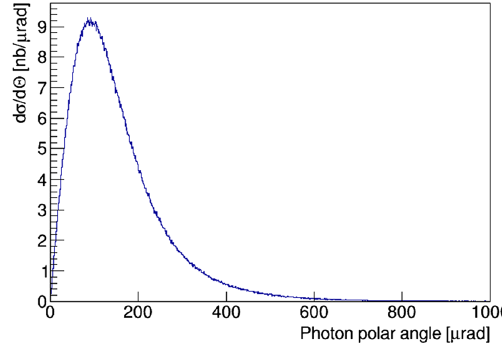
Fig. 3 The bremsstrahlung photon polar angle distribution